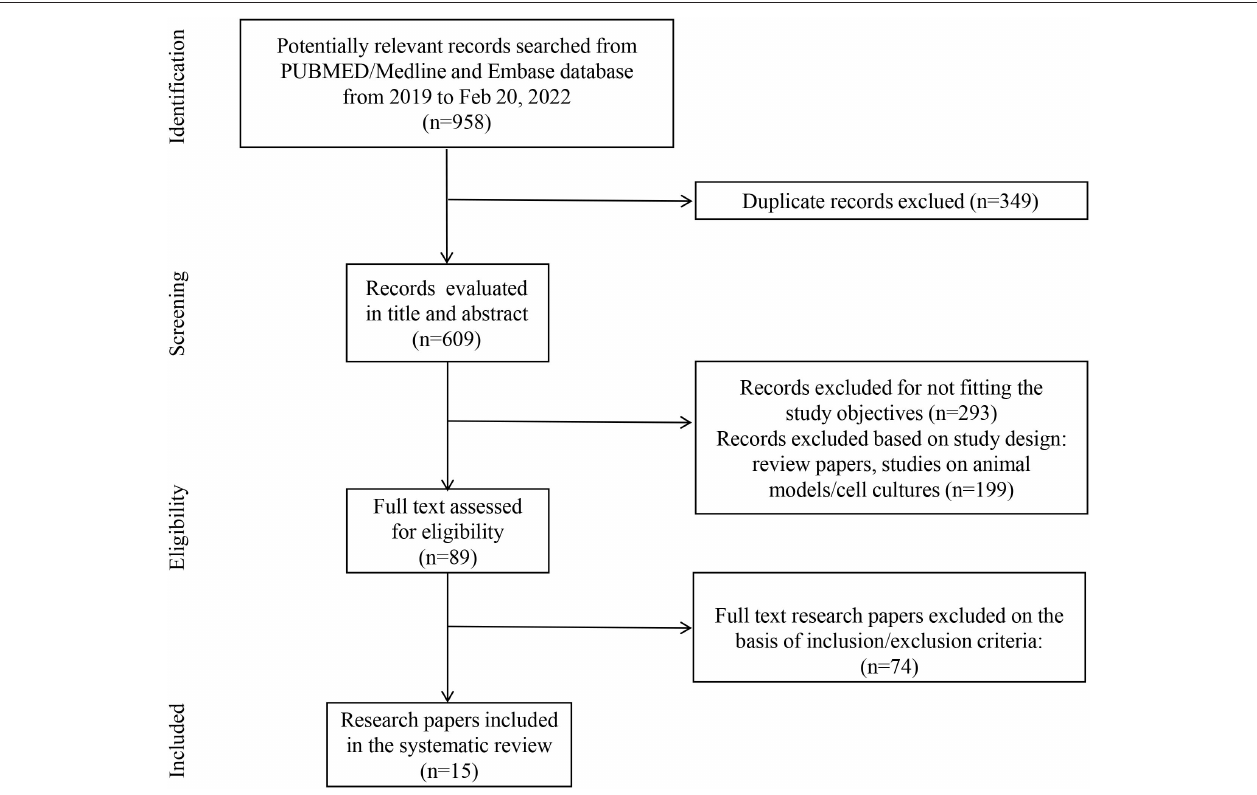
FIGURE 1 | Flow diagram of the study selection